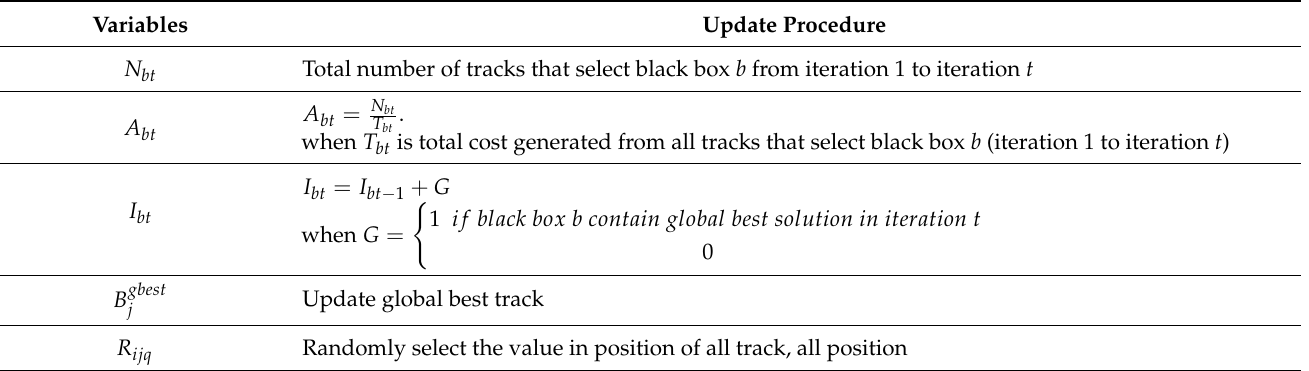
Table 7. List of variables that need to be iteratively updated.